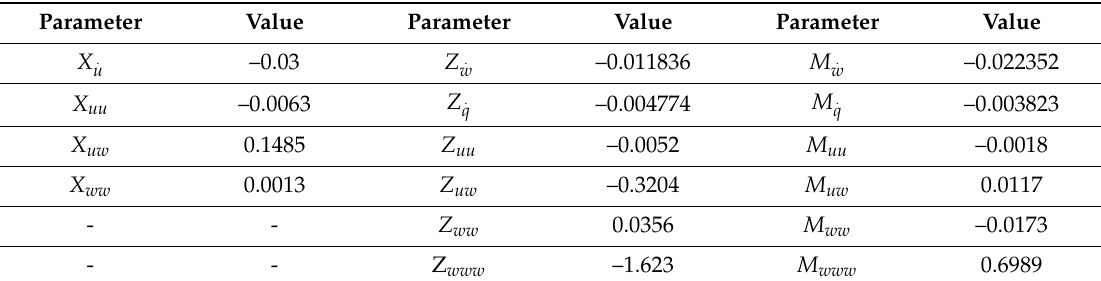
Figure 7. Vertical static drift calculation result for heave motion. Table 2. Dimensionless hydrodynamics coefficients (CFD method).